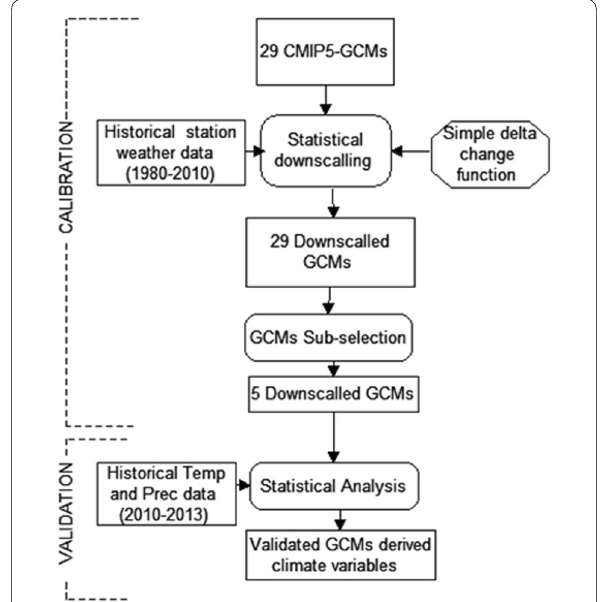
Fig. 8 Schematic diagram showing the work flow to generate future climate